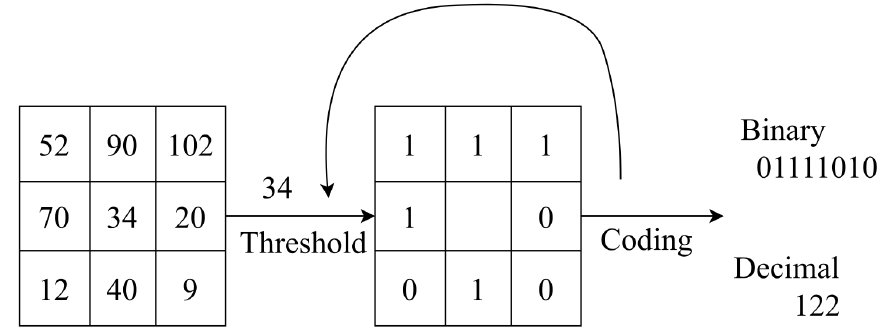
Figure 1. Describes the encoding of the LBP operator.